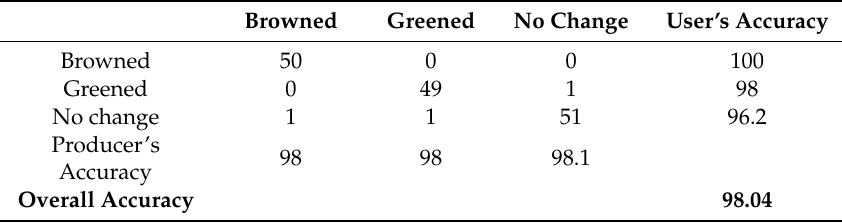
Table 2. Mann–Kendall and Sen’s slope accuracy assessment